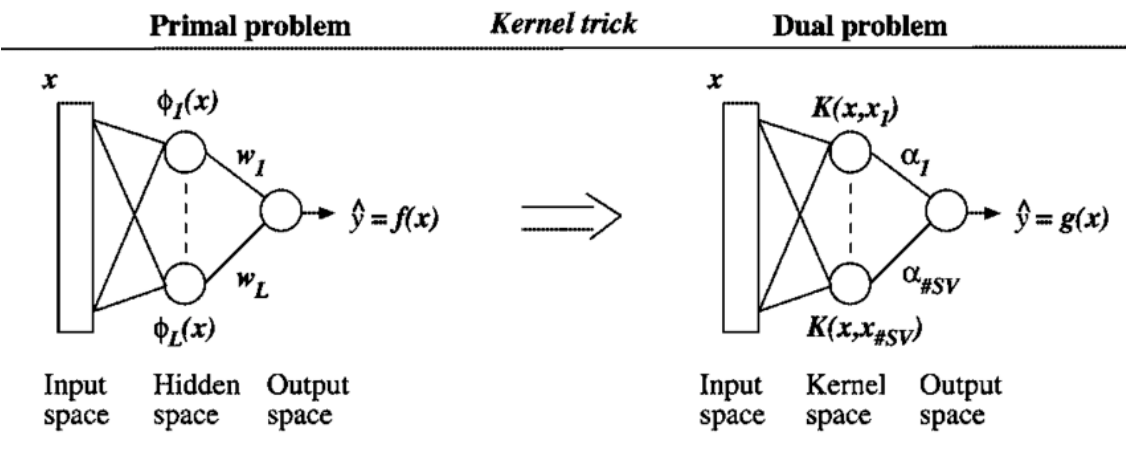
Figure 5. SVM model.